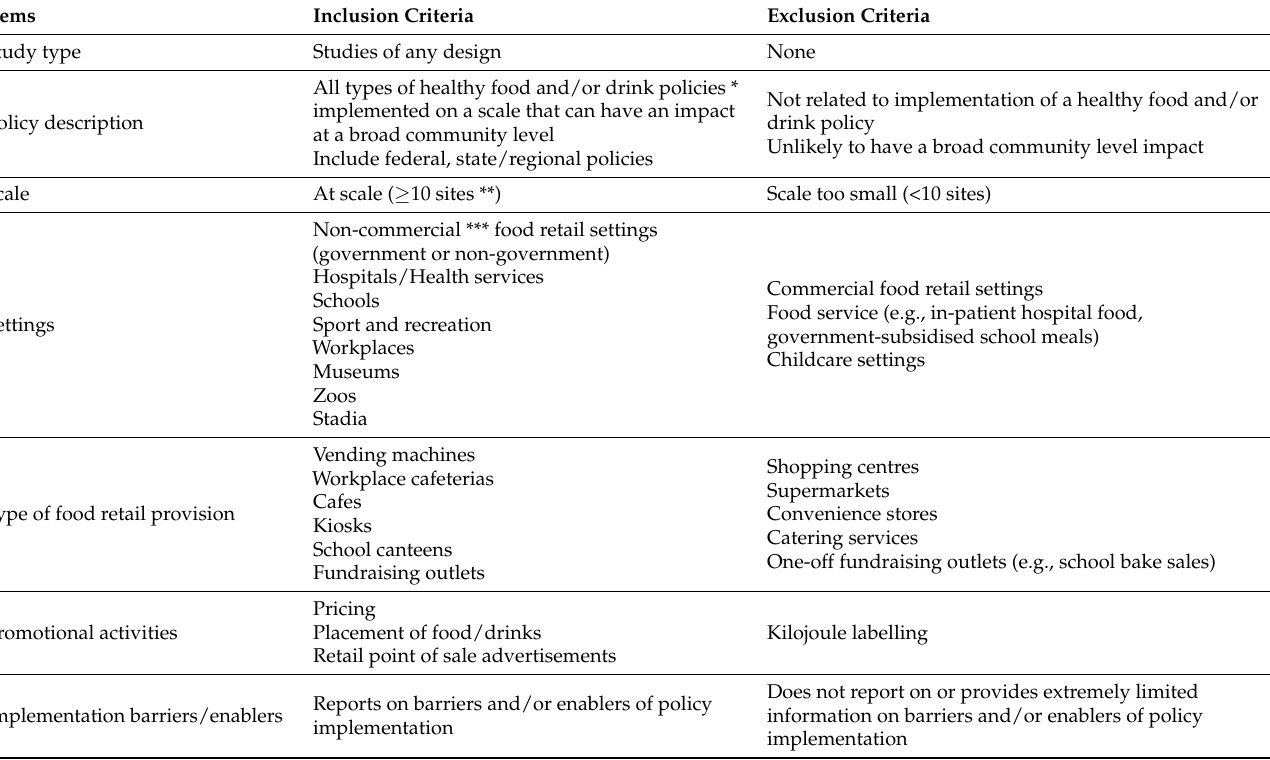
Table 1. Inclusion and exclusion